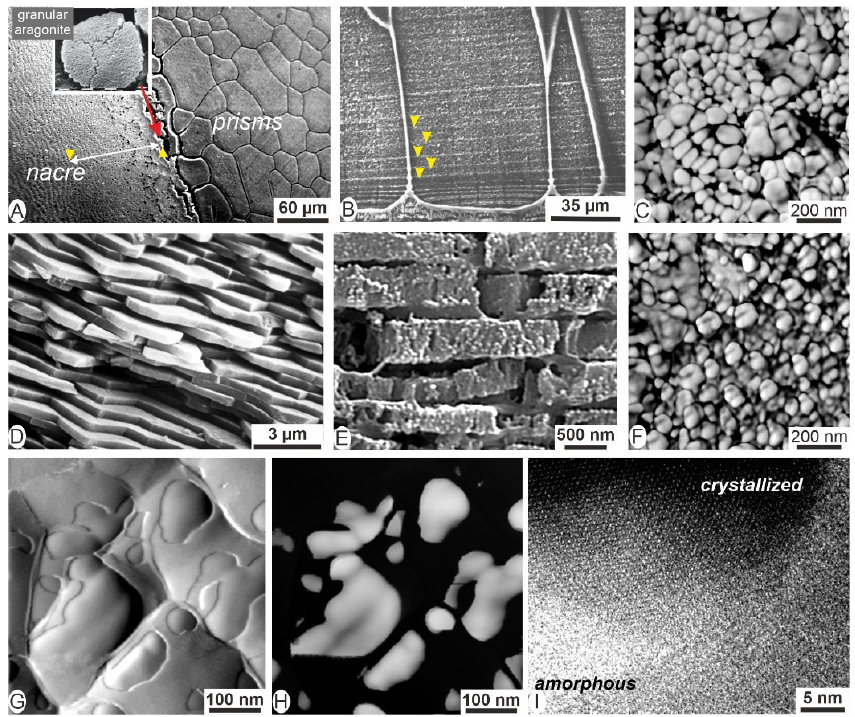
Figure 11. Similarity of ultrastructures in the calcite prisms and nacre of the P. margaritifera . ( A ) Inner side of a valve showing the transition area between the end of prismatic domain (right) and the first occurrence of nacreous area. The nacreous area begins by deposition of aragonite made of sub ‐ micrometric grains. ( B ) SEM image showing the layered structure of prisms. ( C ) AFM phase contrast image showing the granular nanostructure of the prisms. ( D – F ) Ultrastructure of nacreous tablets also built by nanograins. ( G ) AFM amplitude image of the nanogranular structure of the prisms. ( H ) AFM phase image contrast of the same zone, showing black areas (organo ‐ mineral contents) and the mainly mineral gray areas. ( I ) Crystallization of grain core surrounded by per ‐ sistent amorphous material made visible in transmission electron microscopy. In every reported example, the consistency of crystallographic orientation for the mineral grains has been established, contrasting with the absence of the microstructural envelopes. This transforms the mineral secretion mechanism into a free ‐ running miner ‐ alization process, with no remaining indication of the specific micro ‐ structural organiza ‐ tion for both aragonite and calcite. From a biomineralization viewpoint, this suggests different sensitivities between grain and envelope formations regarding the operational stress caused by the grafting process. Therefore, from a practical viewpoint, deciphering the structural alterations in the early mineralization by the pearl sac might be an efficient approach to evaluate the bio ‐ logical degradation of the biomineralization mechanism between pristine nacre pro ‐ duced by the graft as a part of the shell mantle and mineralization by pearl sac resulting from transportation of this graft into the host shell. 5. Conclusions: Instead of a ‘Reversed Shell’ Growth Mode, a Post ‐ Grafting Recovery Process May Help to Understand Early Calcifications in Pearl Results obtained by synchrotron ‐ based characterizations of the earliest mineral depositions in the cultivated pearls clearly disprove their commonly admitted similarity with the periostracum of the Pinctada shells: Contrasting to the regular layering admitted by the “reversed shell” theory, the ear ‐ liest post ‐ grafting mineralizations are highly irregular from both structural and mineralogical view ‐ points;